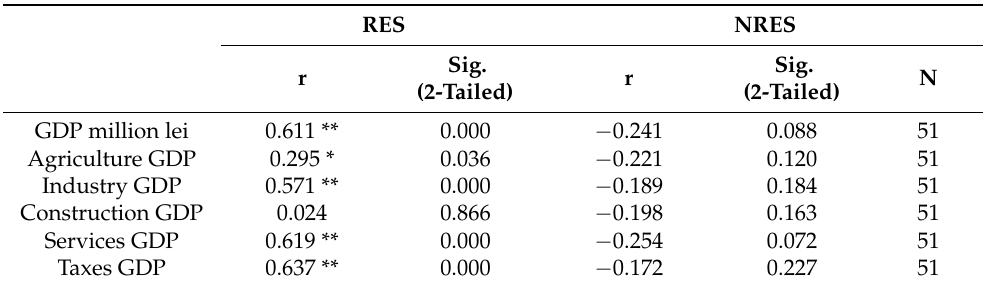
Taxes GDP 0.637 **